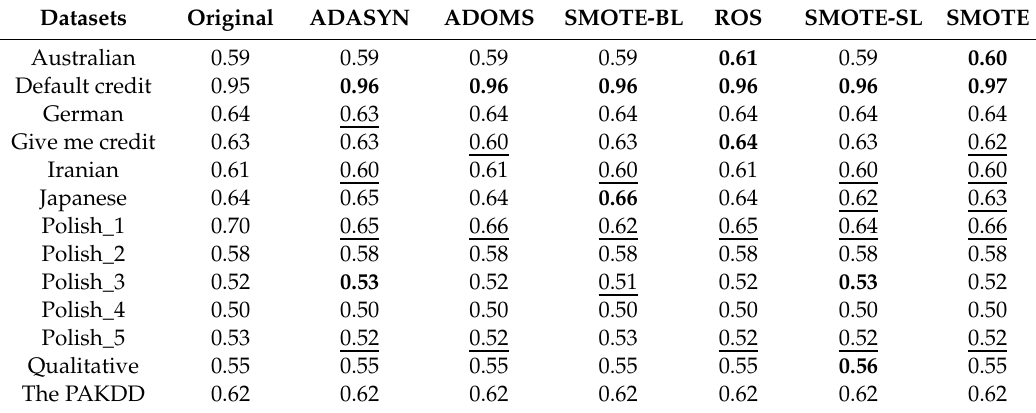
Table 9. AUC for HACT classifier after oversampling algorithms.